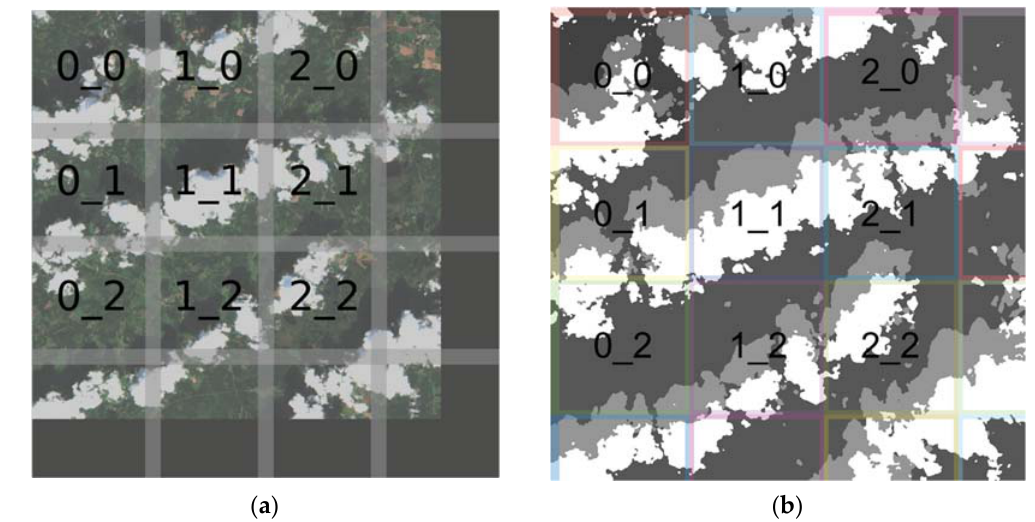
Figure 5. Illustrative images of how full Sentinel-2 image is cropped for prediction and how classification map is rebuilt into the full image with 32 pixels overlap. ( a ) Cropping original Sentinel-2 image for inference. ( b ) Prediction output mask combined into the final image